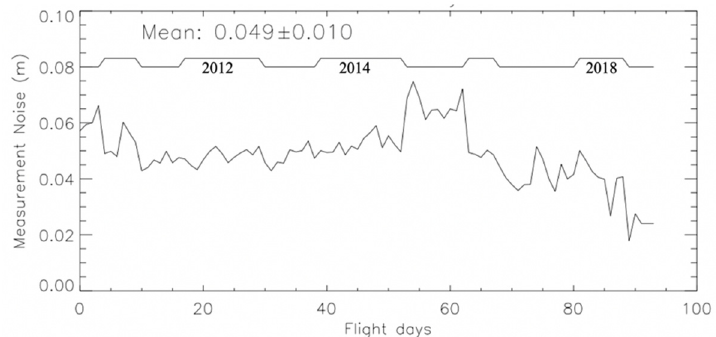
Figure 3. ATM measurement noise for the 94 campaigns from 2009 to 2019. The upper curve marks the measurement years.